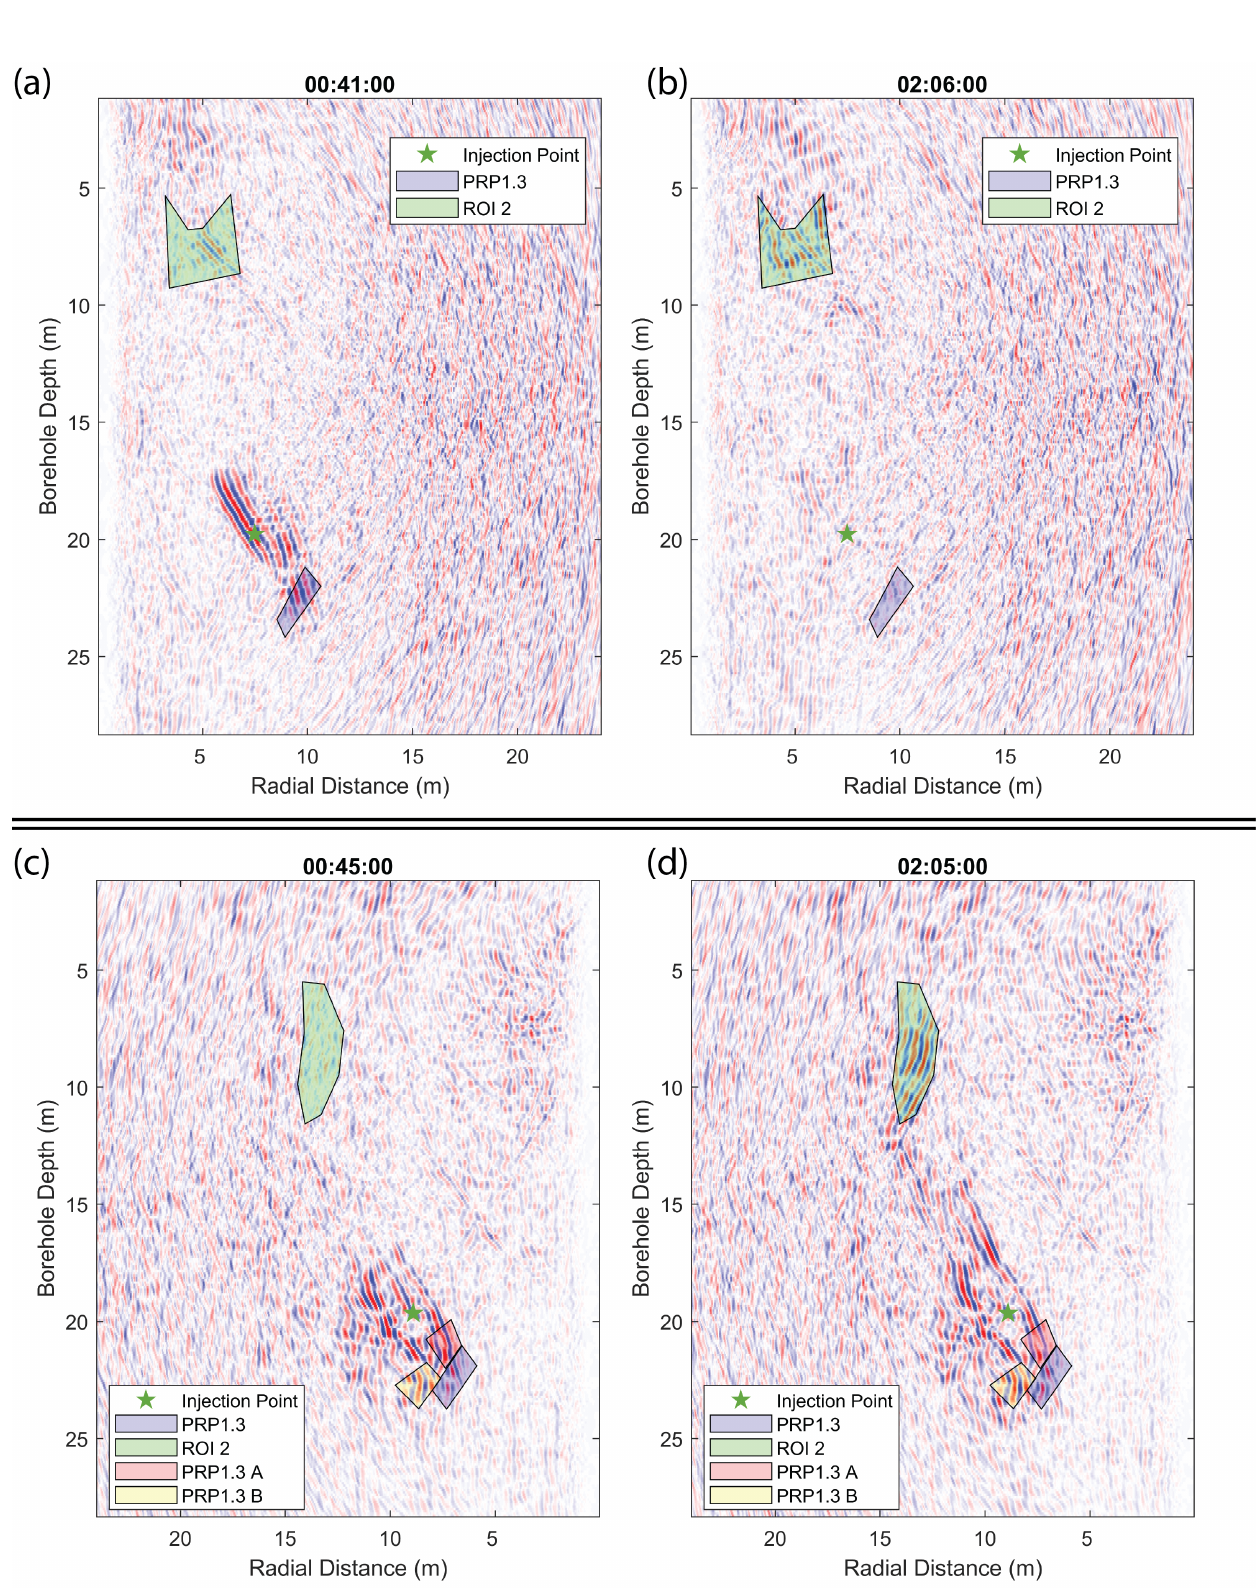
Figure 6. Definition of regions of interest (ROIs) in the GPR reflection surveys. ( a , b ) show different time steps of Experiment 1 monitored from GEO3 and the selected ROIs. ( c , d ) show different time steps of Experiment 2 monitored from GEO1 and the selected ROIs. Figure adapted from Giertzuch et al. [31]. Note that the x -axis with the distance from the borehole has an opposite direction for the two experiments, such that the geometry is better